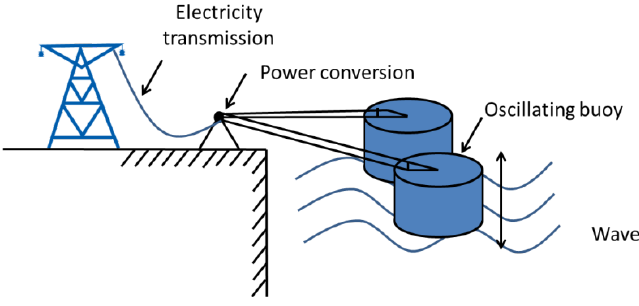
Figure 2. Schematic diagram of the hydraulic oscillating body system.